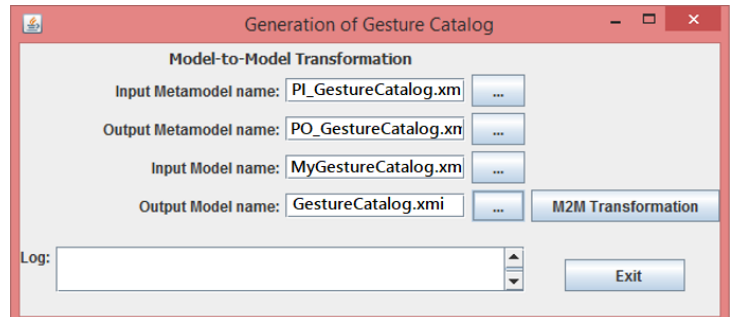
Figure 9. M2M transformation